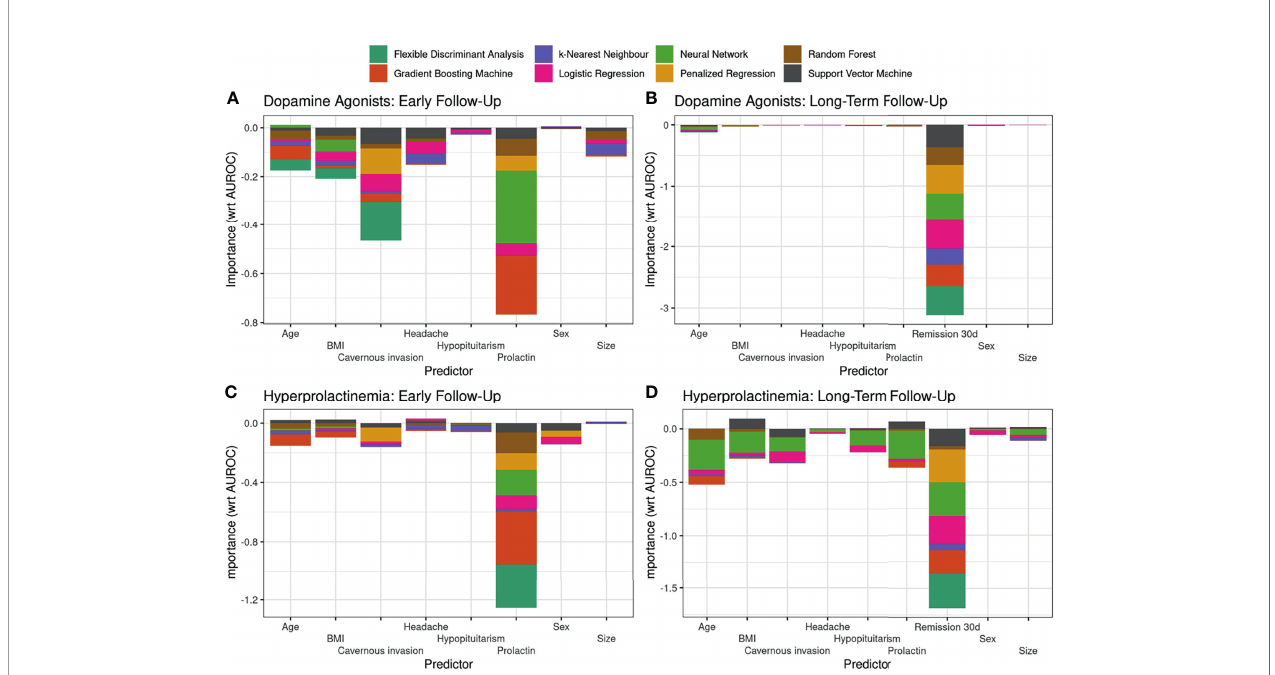
FIGURE 4 | Importance of the available set of variables in predicting early and long-term outcome. The variable importance metric is based on a permutation approach, where the impact of perturbing the values of a given predictor on a particular performance metric [in this case: area under the curve (AUROC)] is assessed: the larger the decrease in the AUROC metric, the more important a predictor is considered. The variable importance is assessed for each classi fi cation algorithm with optimized hyperparameters, and the importance values for each predictor are simply stacked upon each other to illustrate the overall importance of a particular predictor and to visualize the inter-algorithm agreement in the assessment of the importance of a single